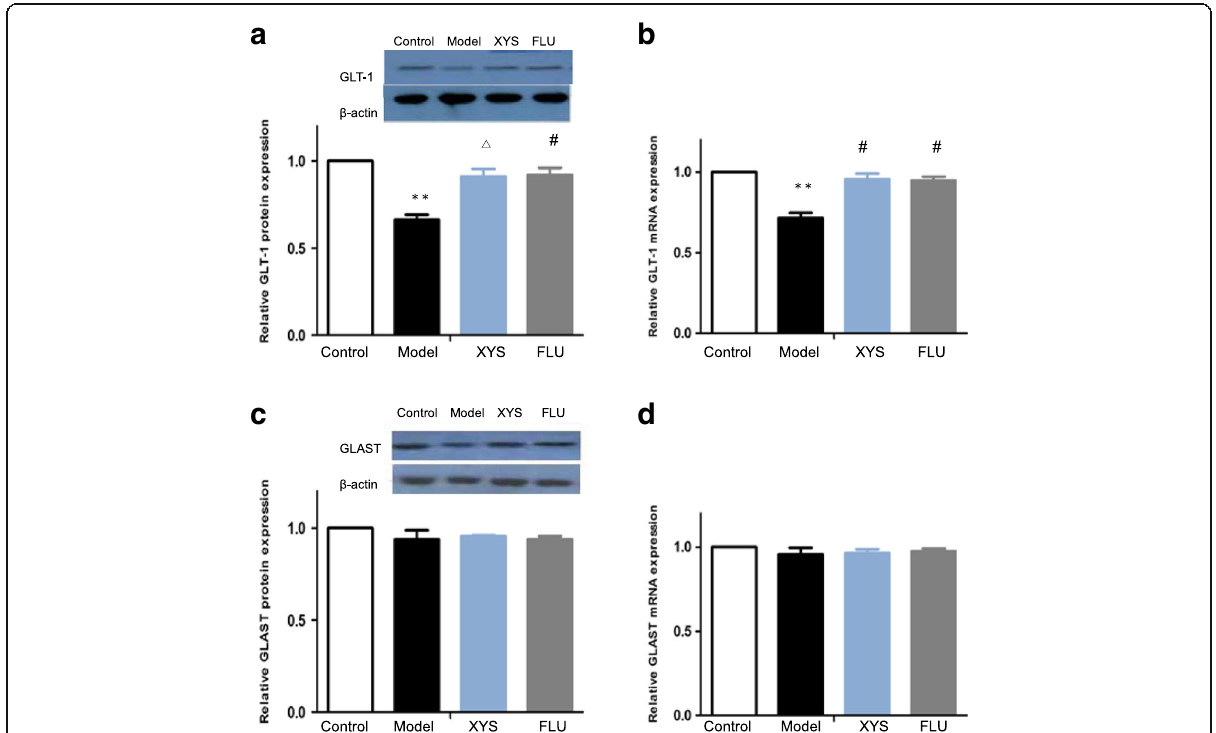
Fig. 5 Alterations of protein and mRNA expressions of GLAST and GLT-1 in the hippocampi of mice by CUMS as well as XYS and FLU treatment. a , c The protein expressions of GLT-1 and GLAST were measured by Western blotting. b , d The mRNAs levels of GLT-1 and GLAST were measured by qRT-PCR. Data were expressed as mean ± S.E.M, n = 5 per group. ∗∗ p < 0.001 vs. control; △ p < 0.05, # p < 0.01 vs.